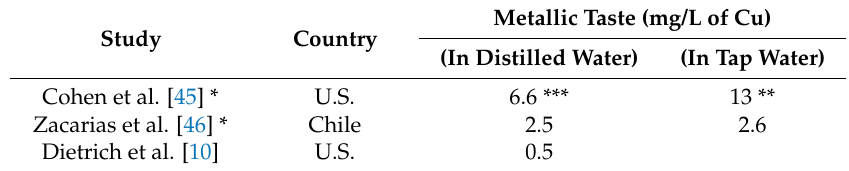
Table 1. Taste threshold concentrations of copper determined in distilled and drinking water.